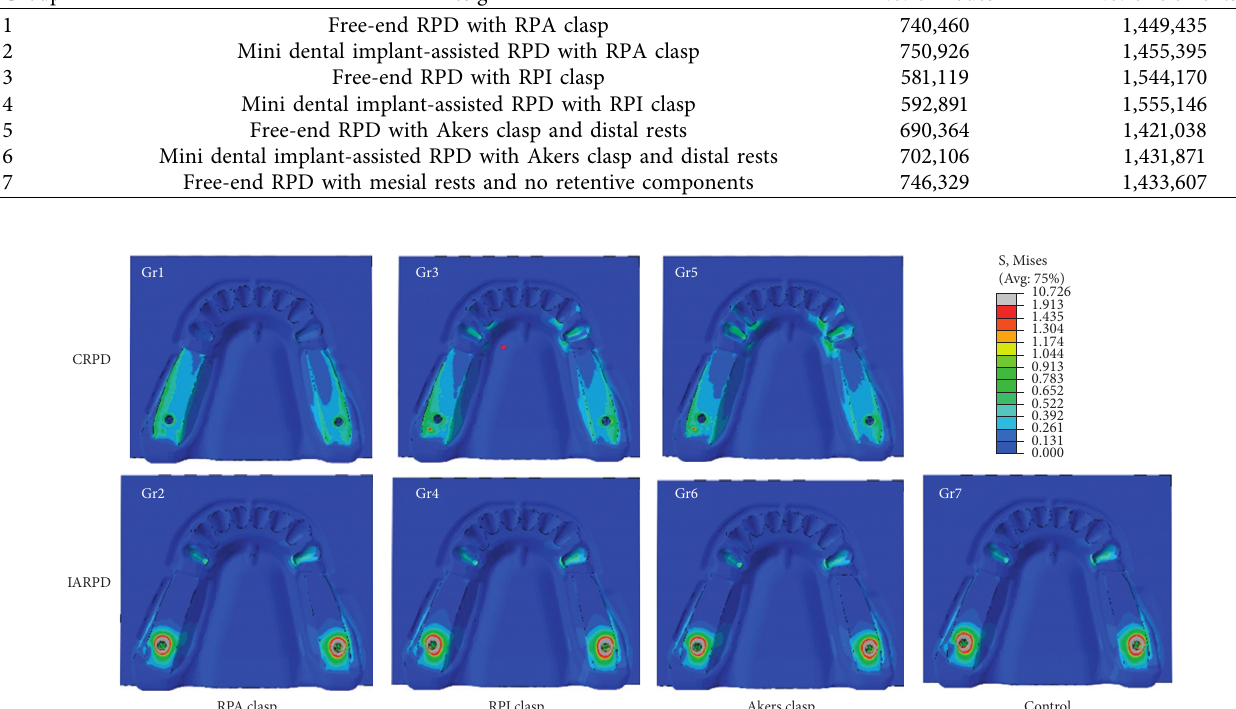
Figure 6: Stress distribution patterns on the edentulous areas of CRPD and IARPD models with various retentive clasp designs. The variation in retentive clasp designs of CRPDs and IARPDs provided less effect on the stress distribution patterns in both groups.